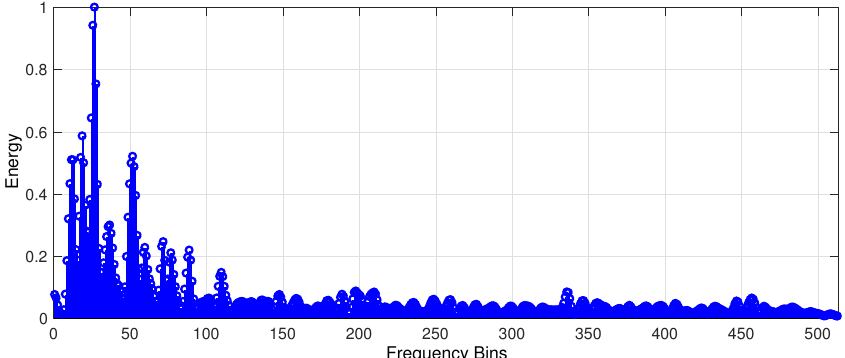
Figure 7. Normalized energy in different frequency bins of observed mixture 1.